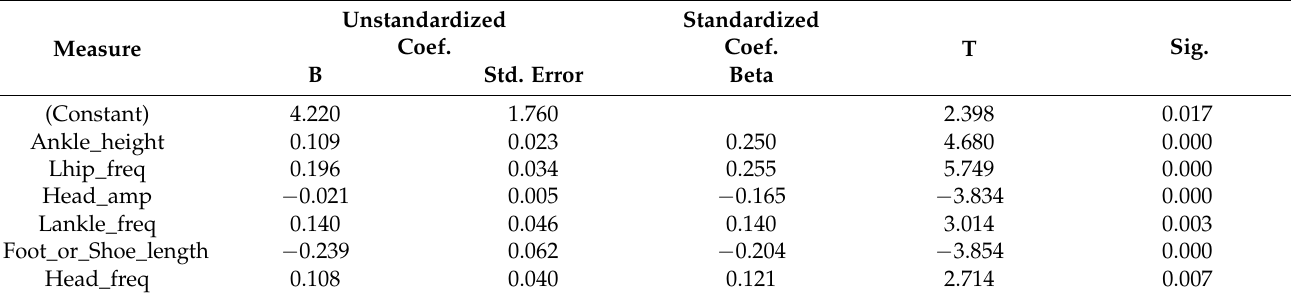
Table 8. Results of Stepwise Regression of SD_hip (Freq.